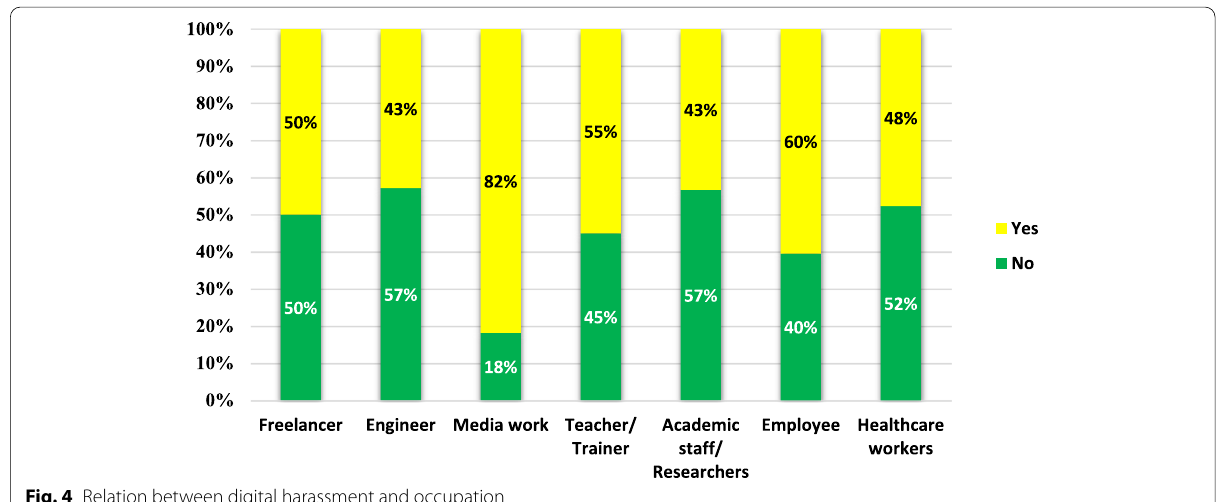
Fig. 4 Relation between digital harassment and occupation